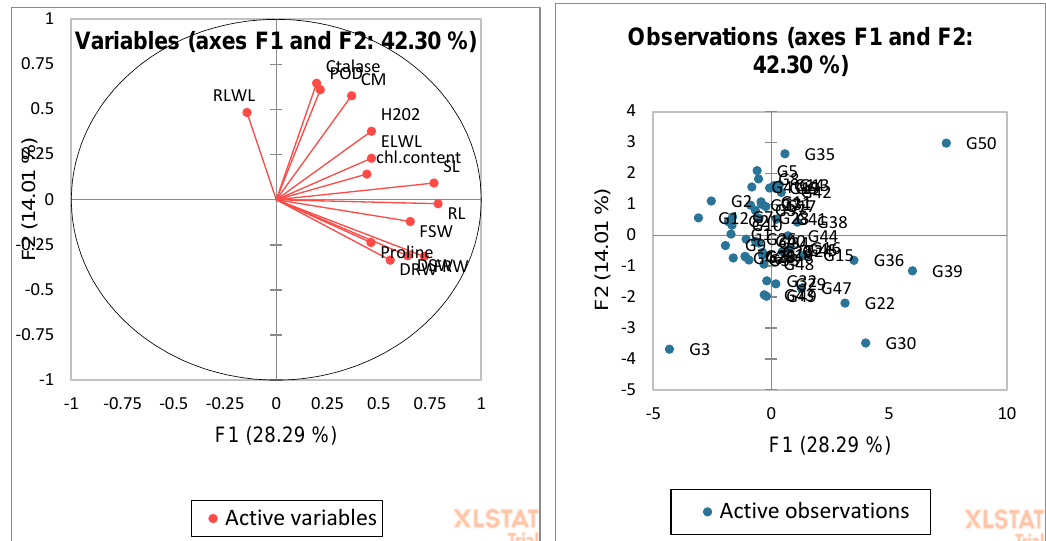
Figure 7. Biplot analysis of 50 cotton accessions for different seedlings characters grown under 75% drought level. Where RL = Root length; SL = Shoot length; FRW = Fresh root weight; FSW = Fresh shoot weight; DRW = Dry root weight; ELWL = Excised leaf water loss, RLWL = Relative leaf water loss, CM S = Cell membrane stability Proln = Proline; POD = Peroxidase; H 2 O 2 = Hydrogen peroxide; CAT = catalase activity. Note: Genotype G50 “Cyto515” (highlighted) at the top right performed best among other genotypes under 75% stress level. Under 50% stress, the accessions in cluster number 5 showed the highest average Table 6. K-means cluster analysis of 50 cotton genotypes grown under 50% drought values for root length (11.28 cm), shoot length (14.40 cm), fresh root weight (1.25 g), fresh shoot weight (1.30 g), dry root weight (0.24) dry shoot weight (0.12 g), CMS% (33.08) and chlorophyll content (37.67 chlorophyll concentration index), Relative water content (56.59), catalase (39.41 U mg −1 protein), proline (0.37 µmol g −1 FW), POD (12.26